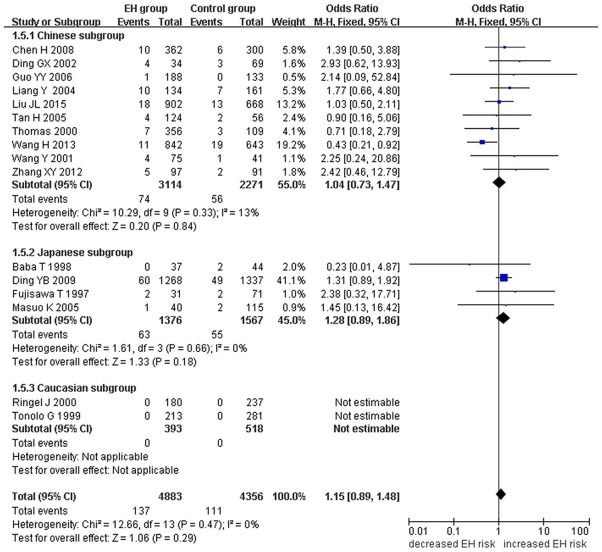
Forest plot of EH associated with ADRB3 gene Trp64Arg polymorphism under a recessive genetic model (AA vs. TA+TT).